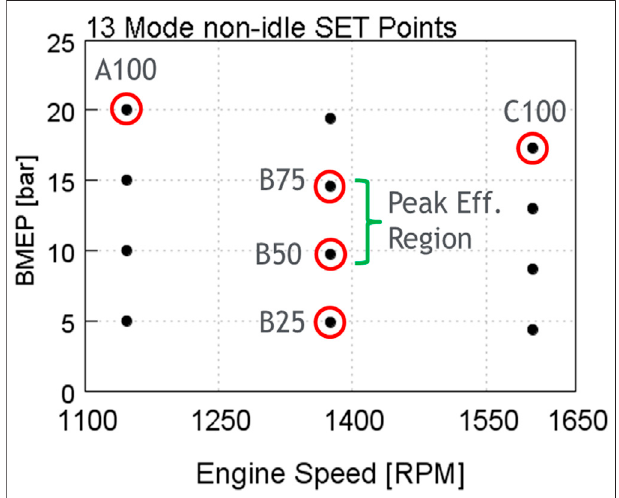
FIGURE 1 | Five key operating points from the 13 mode non-idle SET